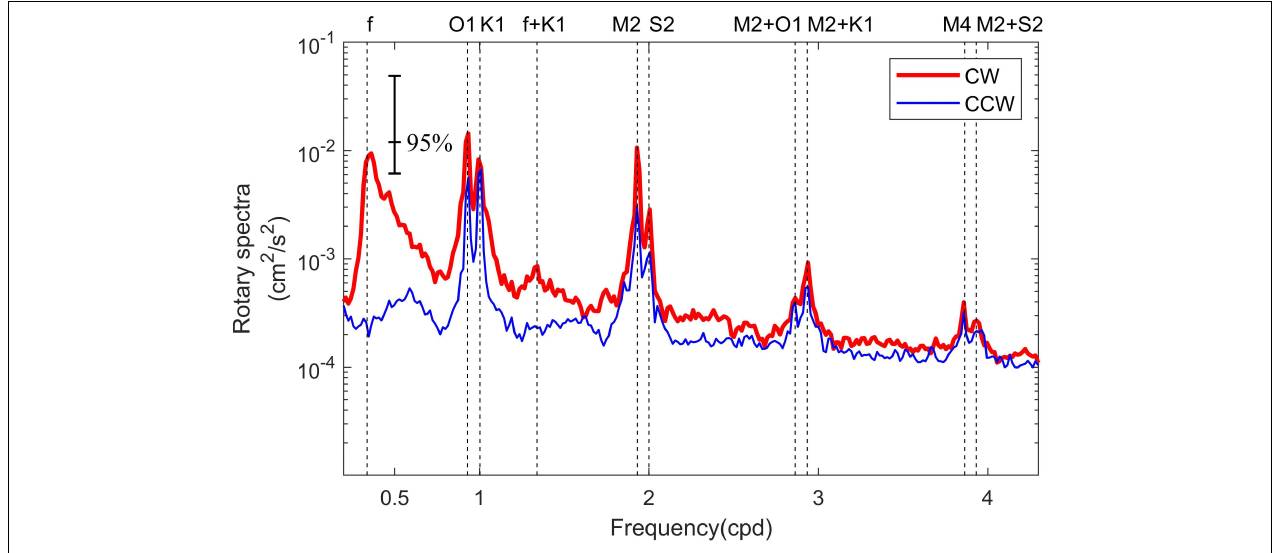
FIGURE 6 | Average rotary spectra of the raw currents from 175 to 740 m for clockwise (red) and counterclockwise (blue)